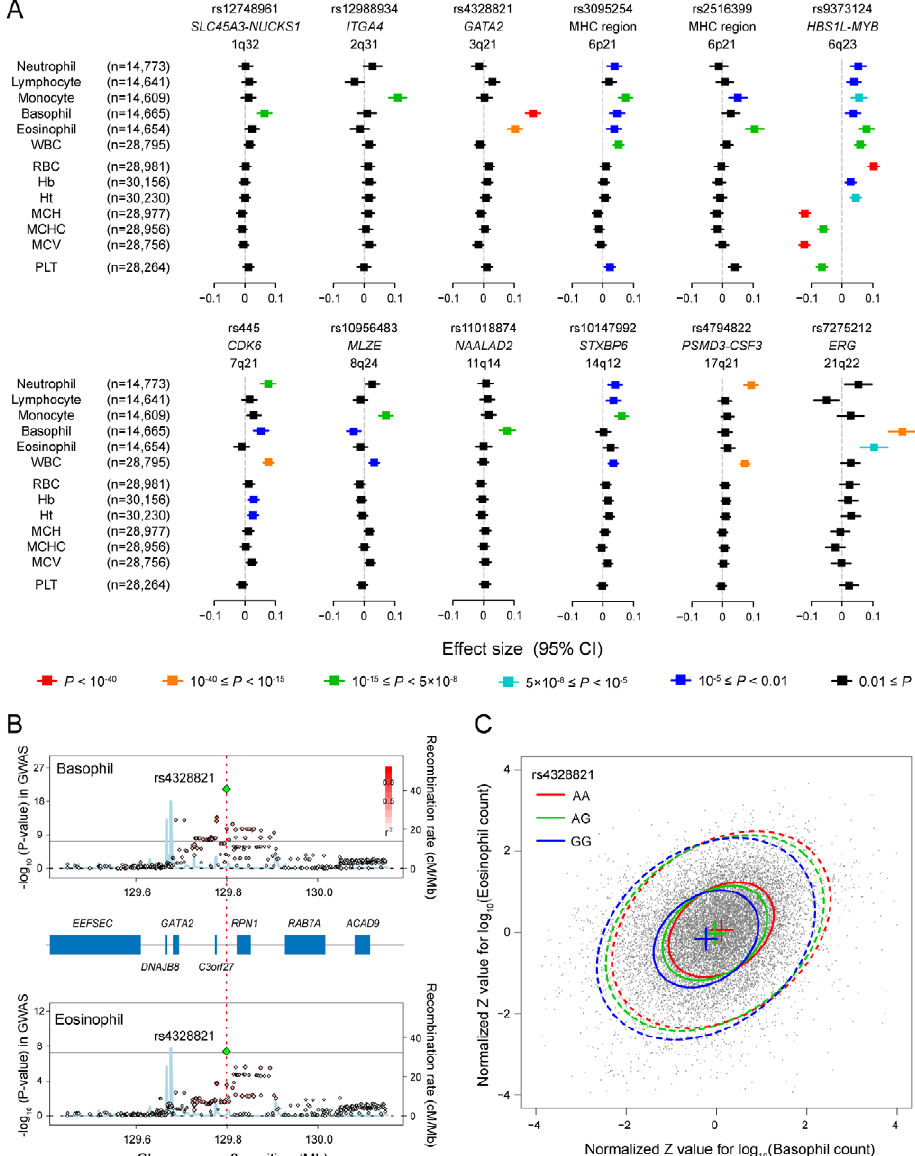
Figure 3. Pleiotropic associations of the genetic loci associated with the WBC subtypes. (A) Associations of the SNPs identified in the GWAS for the WBC subtypes with other WBC subtypes and hematological traits. Effect sizes of each SNP on the normalized traits are aligned vertically in each of the loci, and their color corresponds to the P-values of the associations according to the legend. WBC, total white blood cell count; RBC, red blood cell count; Hb, hemoglobin; Ht, hematocrit; MCV, mean corpuscular volume; MCH, mean corpuscular hemoglobin; MCHC, mean corpuscular hemoglobin concentration; PLT, platelet count; CI confidence interval. (B) Regional plots of the SNPs in the GWAS for the basophil (upper) and eosinophil (lower) counts in the GATA2 locus. Diamond-shaped dots represent -log 10 (P-values) of the SNPs in the GWAS; green indicates the most significantly associated SNP, and the density of the red color represents the r 2 value with the most significantly associated SNP. The blue line shows recombination rates given by the HapMap database. The gray horizontal line represents the genome-wide significance threshold of P =5.0 6 10 2 8 . The middle part indicates the RefSeq genes in the locus. The red vertical dashed line represents the concordance of the peaks of the association at rs4328821 in the GWAS. (C) Scatter plot of the subjects enrolled in the GWAS and the replication study based on the normalized Z values for the basophil and eosinophil counts. The center, 50% probable ellipse, and 95% probable ellipse of the subjects with AA (red) / AG (green) / GG (blue) genotypes of rs4328821 are indicated as crosses, solid ellipses, and dashed ellipses,